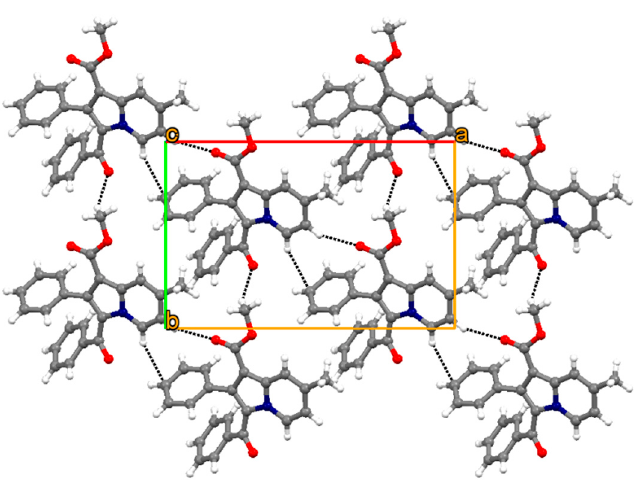
Figure 3. Molecular assembly of 4a shown along [1 1 0] plane through weak C–H...O and C–H… π hydrogen bondings.